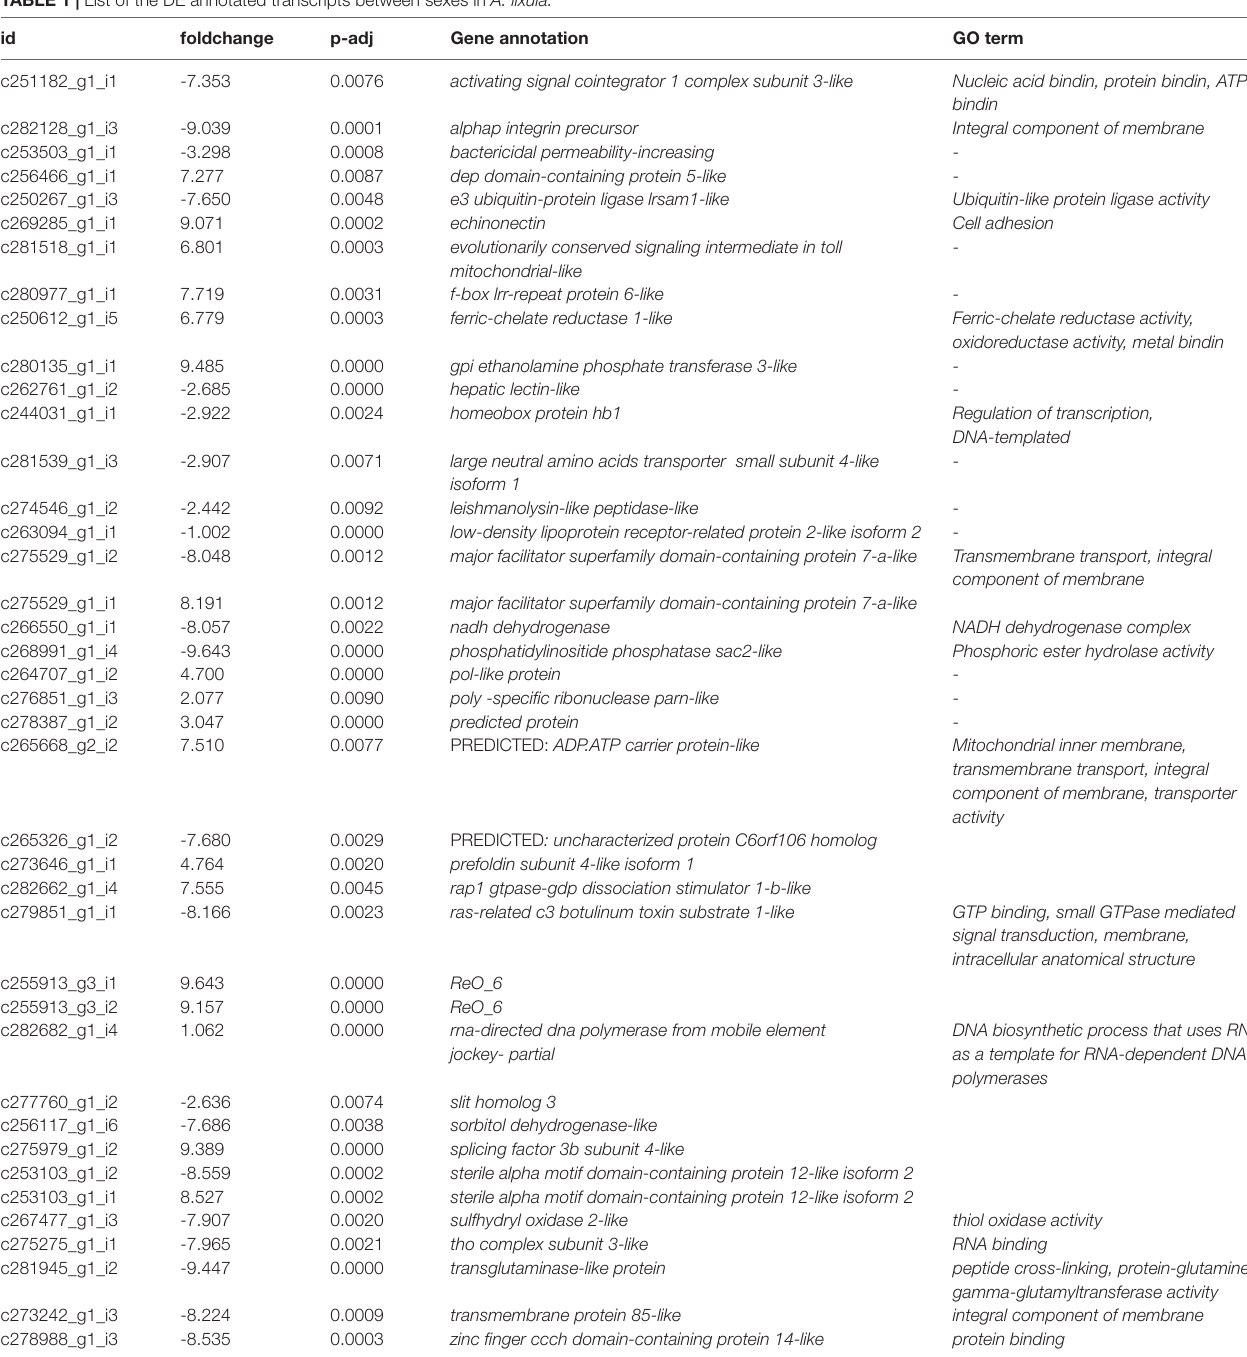
TABLE 1 | List of the DE annotated transcripts between sexes in A.